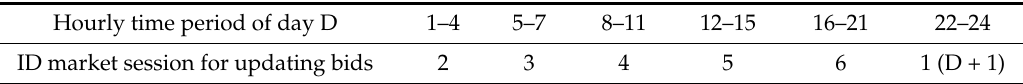
Table 1. Rules for updating energy bids for day D in intraday